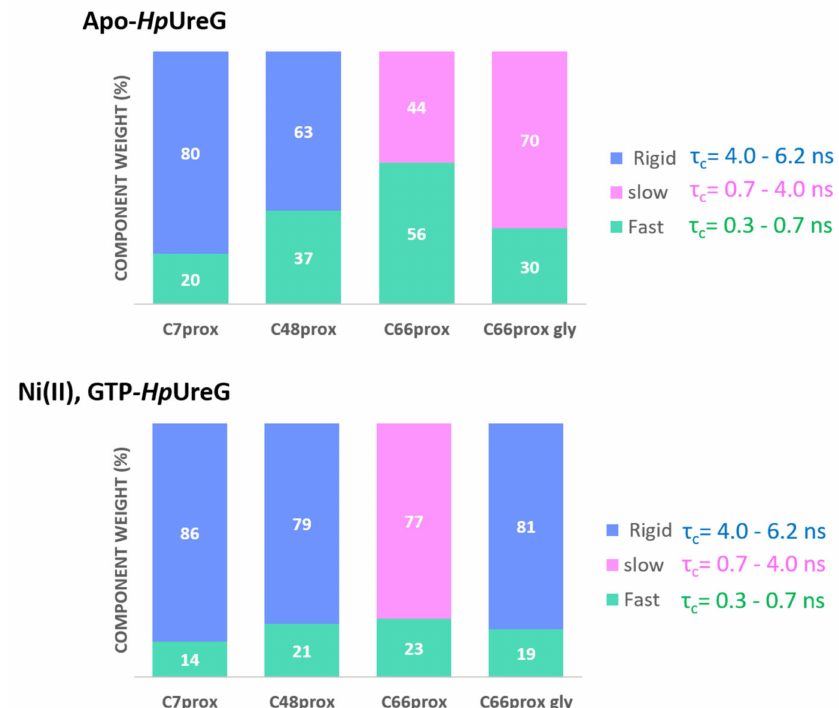
Figure 3. Conformational distribution of Hp UreG variants plotted in terms of the relative amount of the conformations obtained from simulation of EPR spectra. The di ff erent conformational ensembles are indicated using di ff erent colors and the relative correlation times are